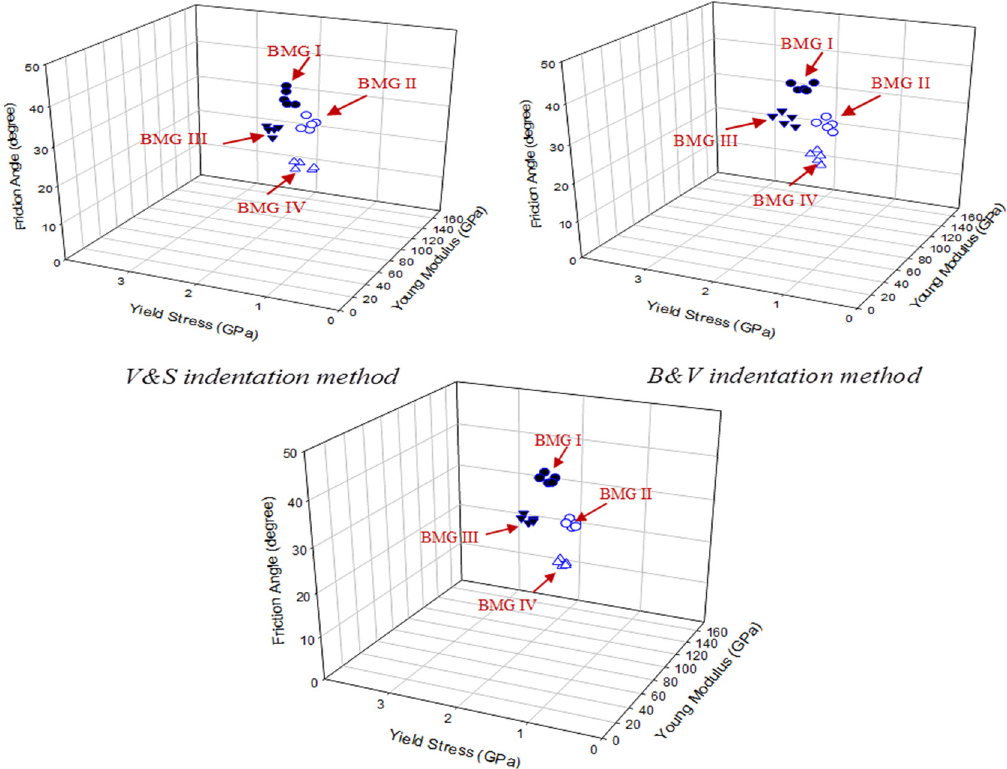
Figure 12. Illustration that there were a few material data sets over a small region matching the input data. This suggests that the combination of spherical and Berkovich indenters could produce unique results.